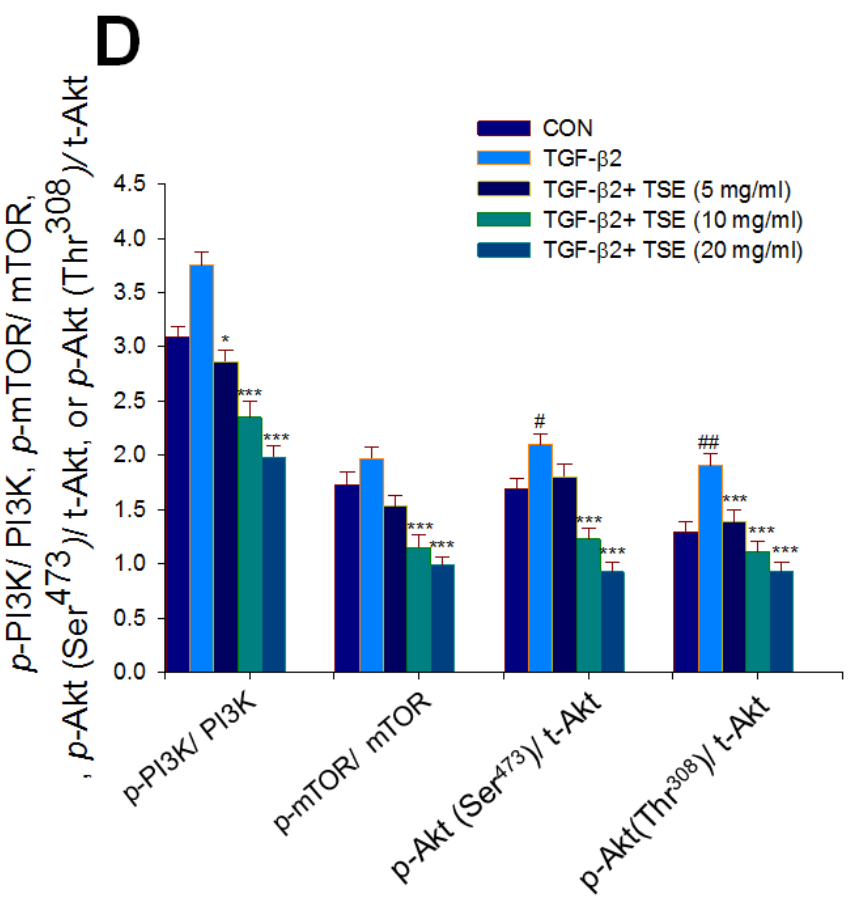
Figure 8. Effects of TSE on expression levels of p - JUN/ JUN, p -ERK1/2/ ERK1/2, p -p38/ p38, p -PI3K/ PI3K, p -mTOR/ mTOR, p -Akt (Ser 473 )/ t-Akt, and p -Akt (Thr 308 )/ t-Akt in SRA01/04 cells by Western blot. ( A ) representative image, and ( B ) quantification of the p - JUN/ JUN, p -ERK1/2/ ERK1/2, and p -p38/ p38 to β -actin. Protein was separated by 12% SDS-PAGE. ( C ) representative image, and ( D ) quantification of p -PI3K/ PI3K, p -mTOR/ mTOR, p -Akt (Ser 473 )/ t-Akt, and p -Akt (Thr 308 )/ t-Akt to β -actin. Protein was separated by 12% SDS-PAGE. ( C ) representative image, and ( D ) quantification of p -PI3K, p -mTOR, p -Akt (Ser 473 ), and p -Akt (Thr 308 ) to β -actin. # p < 0.05 or ## p < 0.01 in comparison to control cells. * p < 0.05 or *** p < 0.001 in comparison to TGF- β 2-induced control cells. Data are the means ± SE (n =